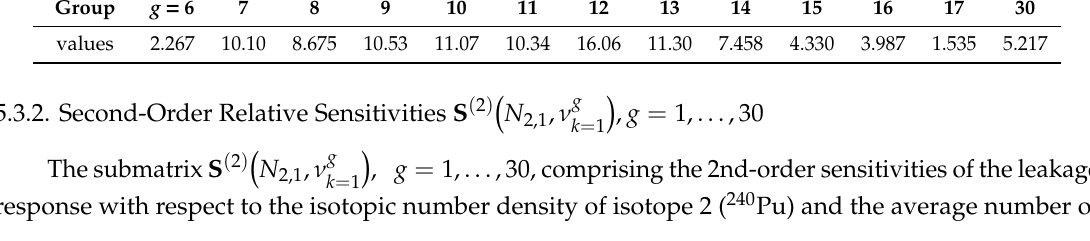
, g = 1, ... ,30, having absolute values greater than 1.0.